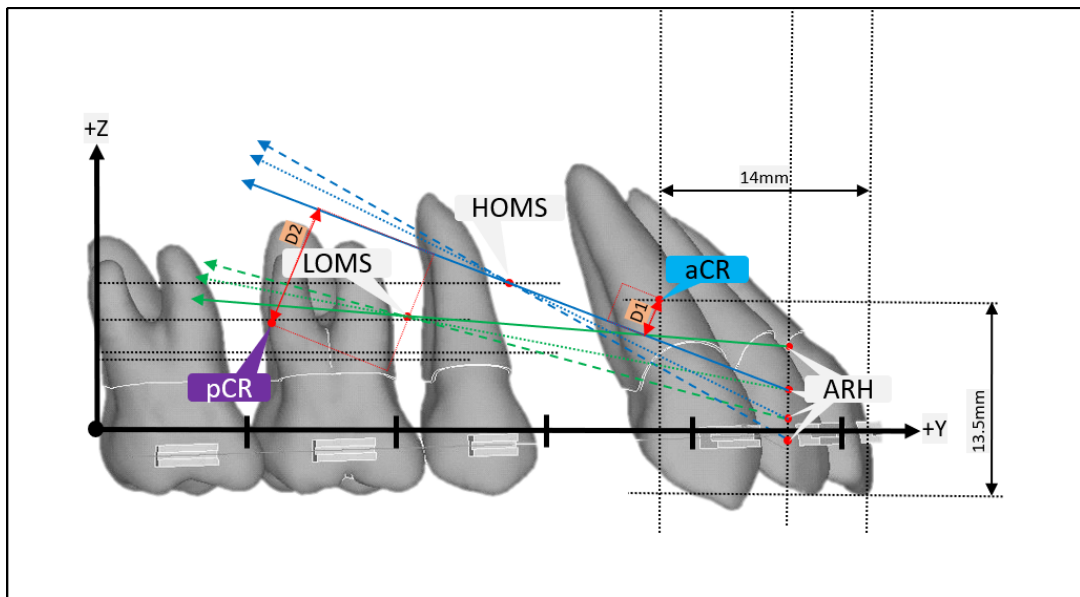
Figure 9. A schematic diagram of the CR and the Force vector in Initial. aCR, anterior teeth’s CR; pCR, posterior teeth’s CR; D1, the shortest distance between the traction force vector and aCR; D2, the shortest distance between traction force vector and pCR.